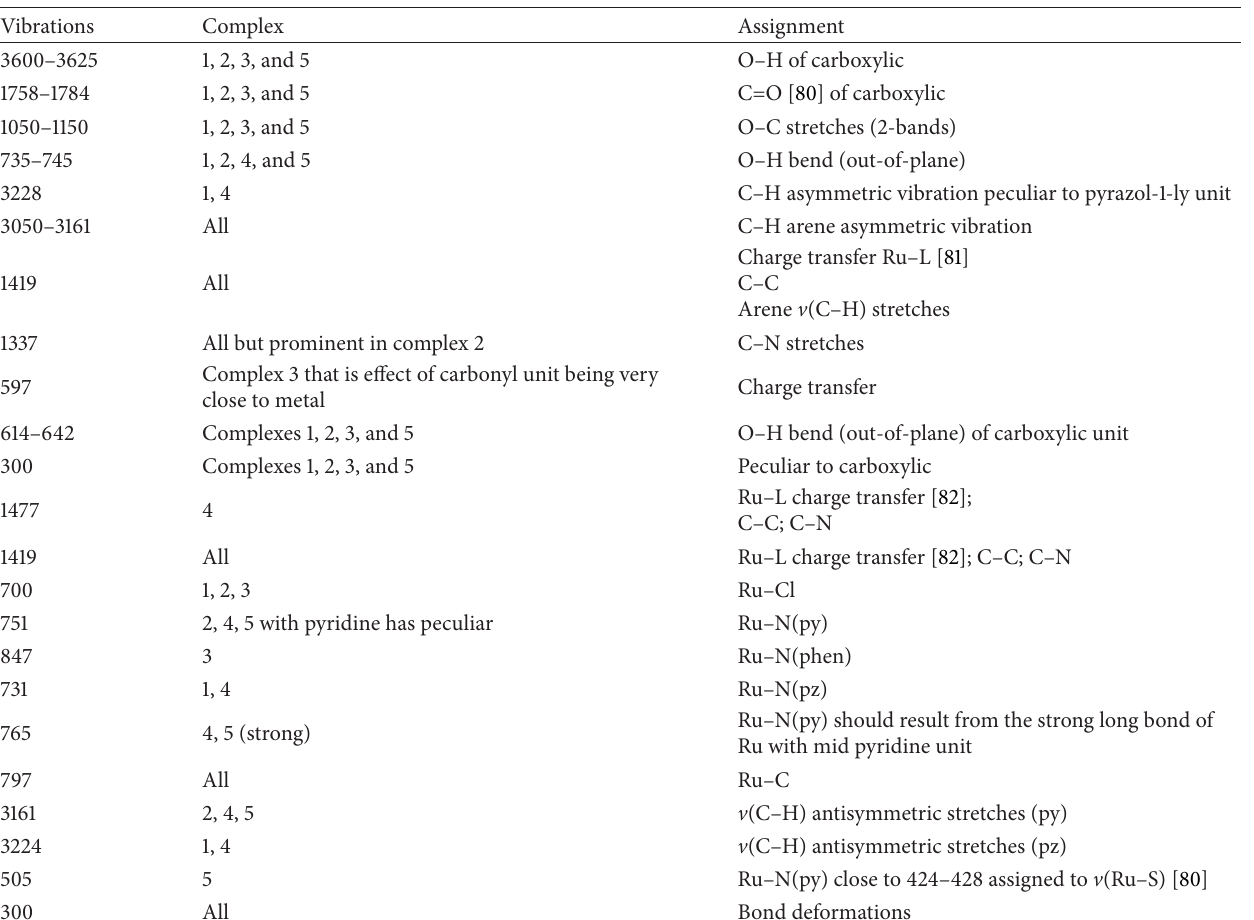
Table 2: The assignment of the IR vibrations to different bonds in the